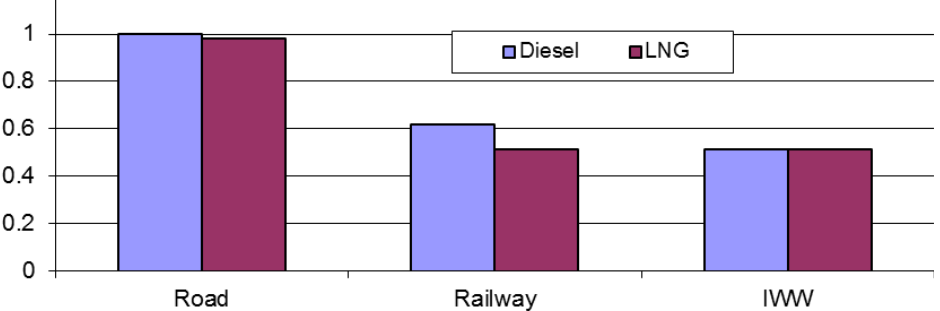
Figure 7. Transport mode energy comparative index (K) for the transportation of 80 TEU between Klaipeda container terminal and Kaunas FEZ free economic zone by different transport roads using diesel and LNG fuels.